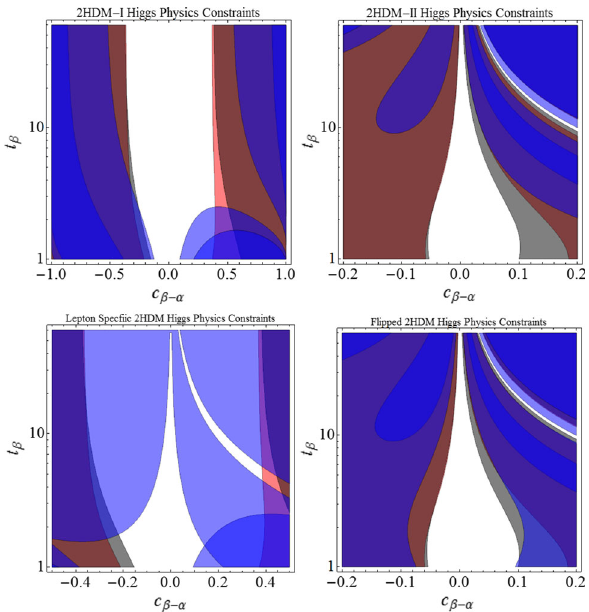
(cid:5) (cid:4) Fig. 4 Constraints in the c β − α , t β plane on the four types of flavor- conserving 2HDMs, coming from Higgs signal strength measure- ments [47,48]. The signal strengths we have considered are μ γγ ( red ), μ μ ZZ , WW ( gray ), and bb ,ττ ( blue